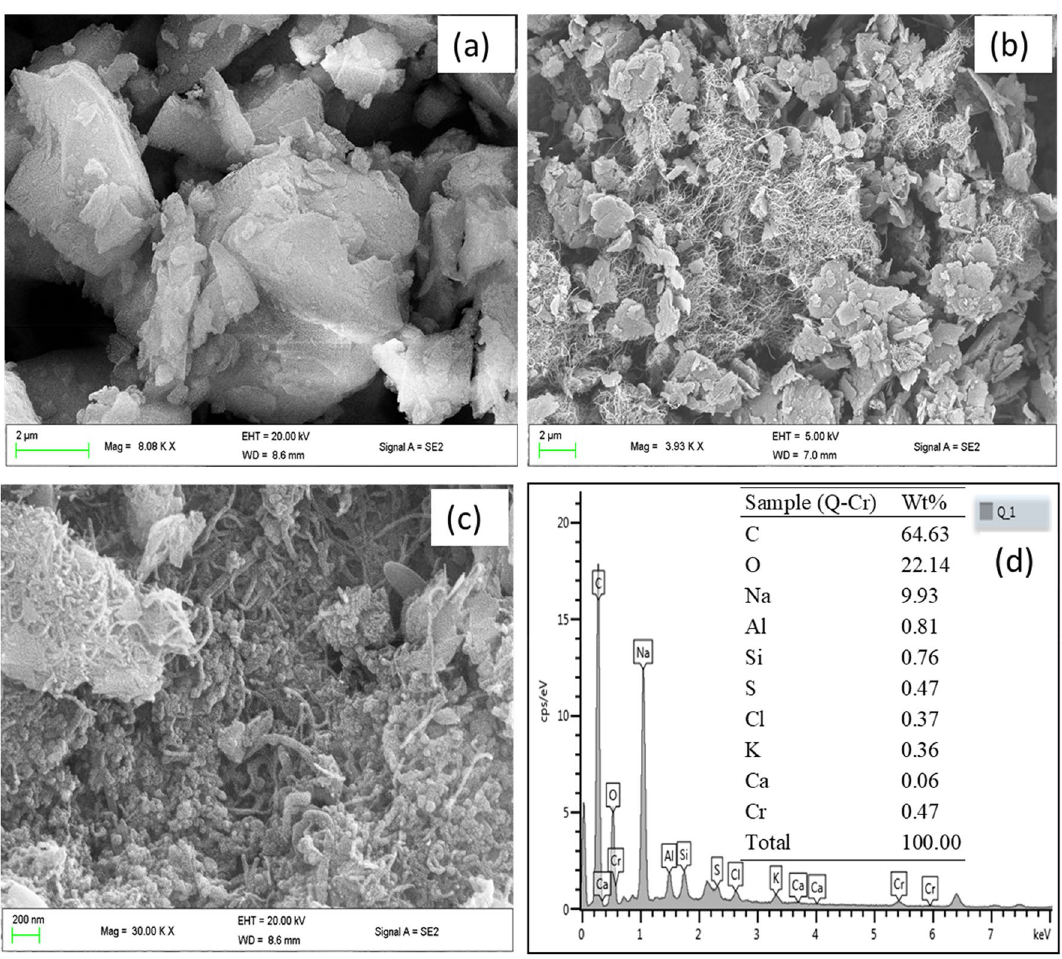
Figure 1. The SEM micrographs of ( a ) PQ, ( b ) Q, ( c ) Q-Cr and the EDX spectrum of Q-Cr (inset: Table of the elemental composition of the spot